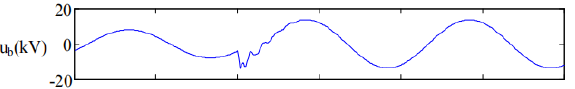
Fig. 4. The reconstructed b-phase voltage waveform of AG fault in line 1